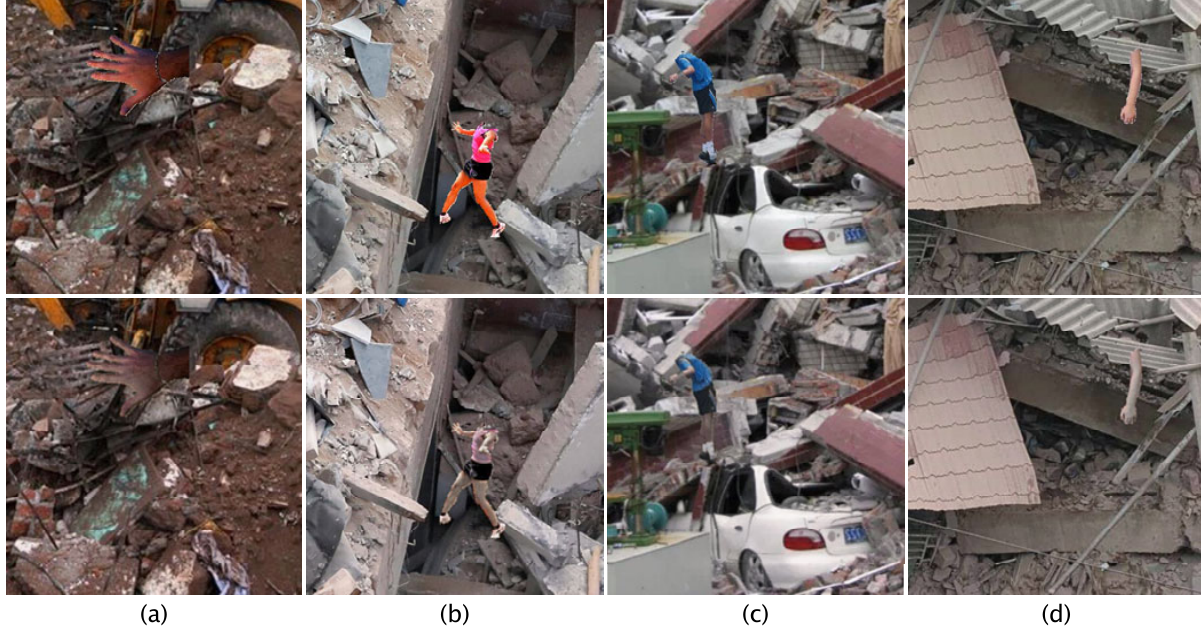
Figure 4. Qualitative results. The first row shows composite images, and the second row is the corresponding harmonious images generated by our network. Table 1. Comparison of the accuracy of the YOLOv5 pretrained on COCO and the proposed fine-tuning models. Fine-tuned on Speed Model AP@[0.5:0.95] AP@0.5 (ms) composite